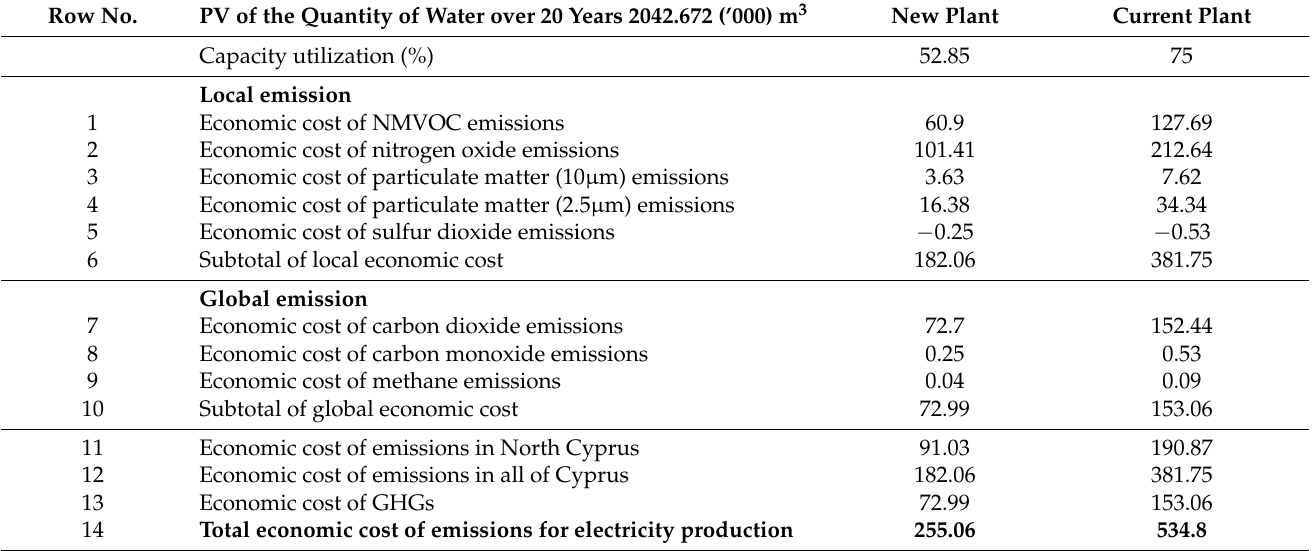
Table 10. Present value at 8% of the emission costs in terms of equal production in the two plants, (’000)